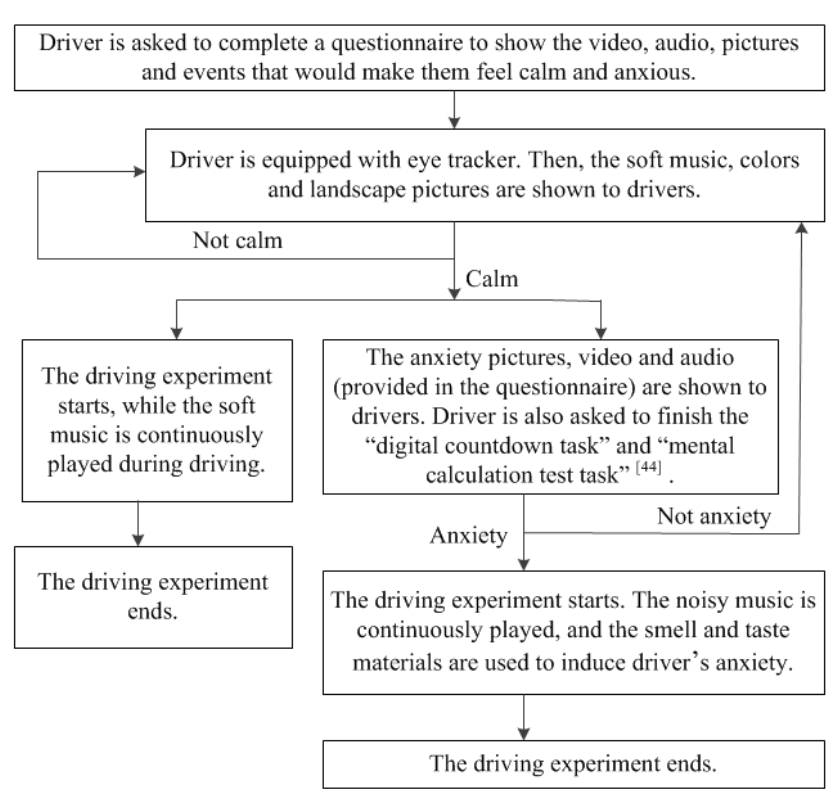
Figure 7. Driving experiment procedure [44].